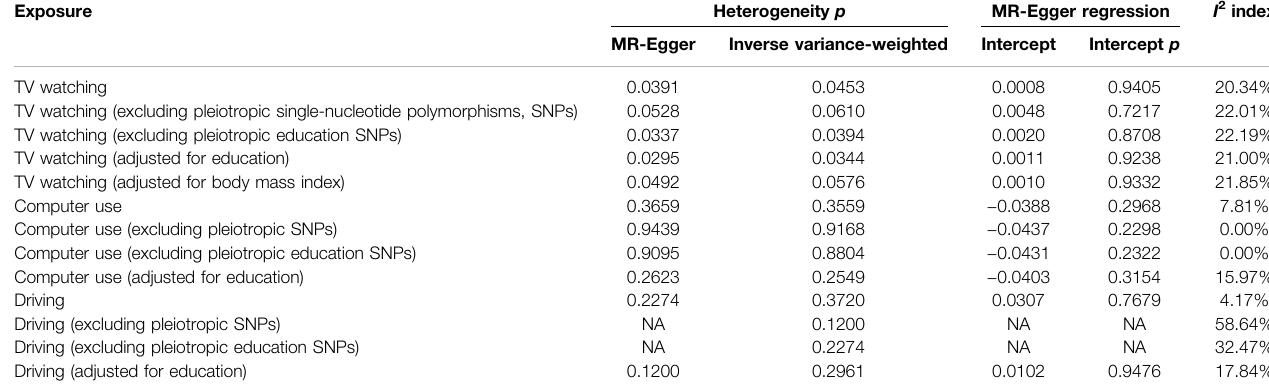
TABLE 4 | MR-Egger regression and heterogeneity analysis of the correlations between television watching, computer use, driving, and lung cancer risk.